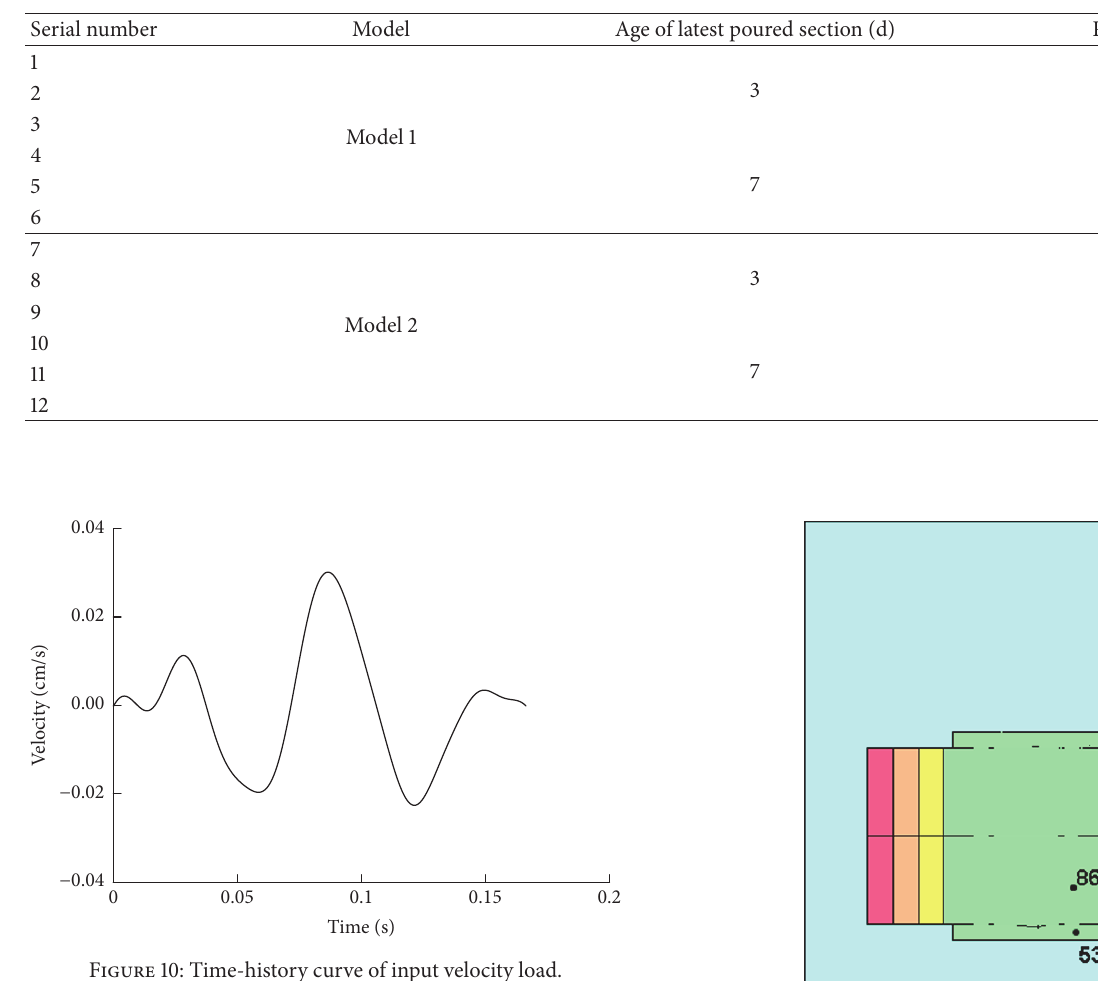
Table 5: Simulation conditions.